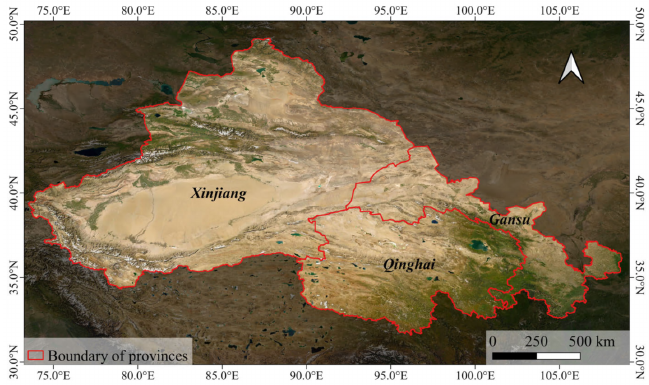
Figure 1. Geographical location of the study